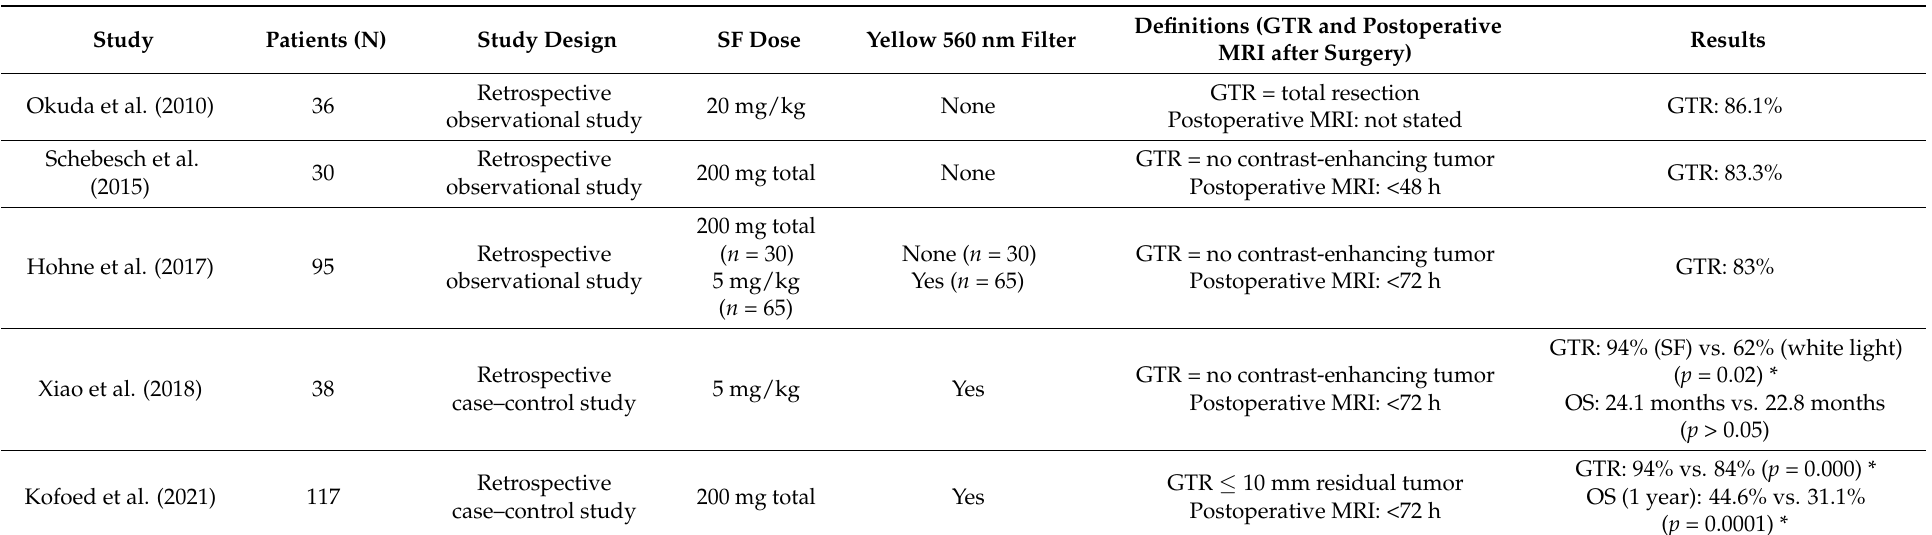
Table 3. Overview of studies with SF in brain